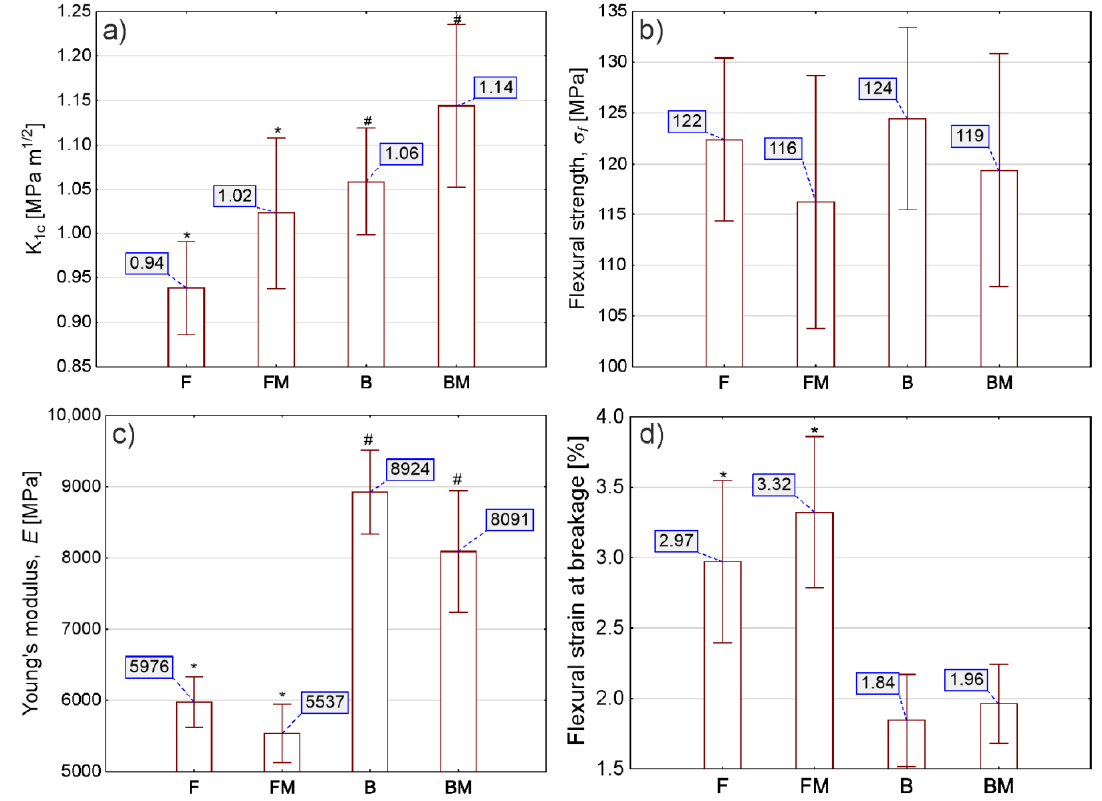
Figure 3. Mechanical properties of the tested materials: ( a ) fracture toughness, K Ic ; ( b ) the flexural strength σ f ; ( c ) the Young’s modulus, E ; and ( d ) the flexural strain at breakage, ϵ f . Bars (I) represent standard deviation. Symbol (*) denotes statistical differences between the results obtained with F and FM sample, whereas # denotes statistical differences between the results obtained with B and BM sample.